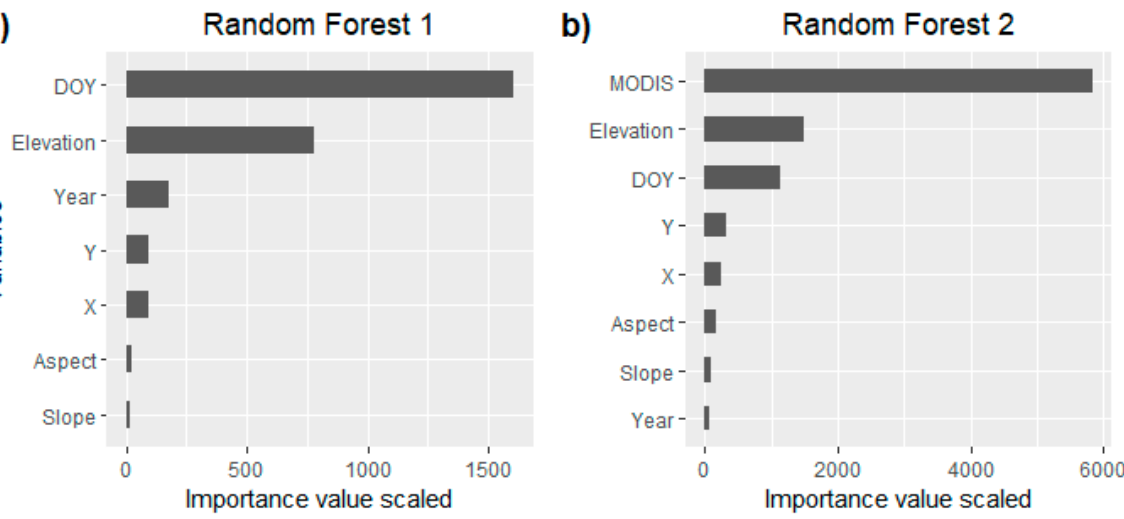
Figure 10 . Variable importance of the regression random forests respectively used in step 1 ( a ), used to retrieve the gap-filled MODIS now data time series, and in step 2 ( b ), used to retrieve the daily high resolution snow cover time series.